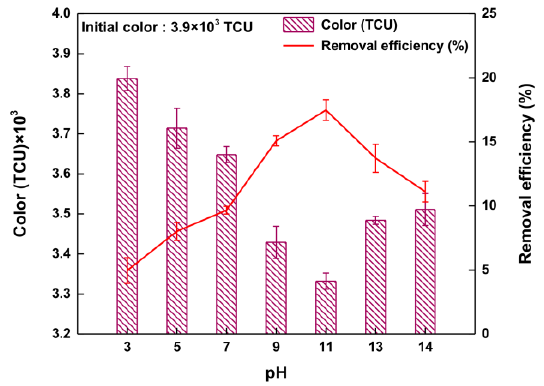
Figure 4. Removal efficiency of color with various pH values during O 3 oxidation.